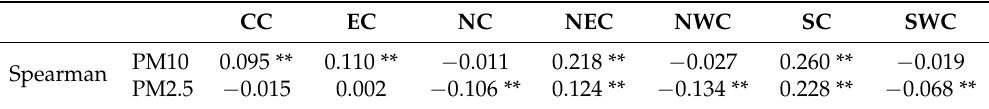
Table 1. The correlation between particulate matter (PM) concentrations and crop residue burning occurred in different regions of China during 2013 to 2017.